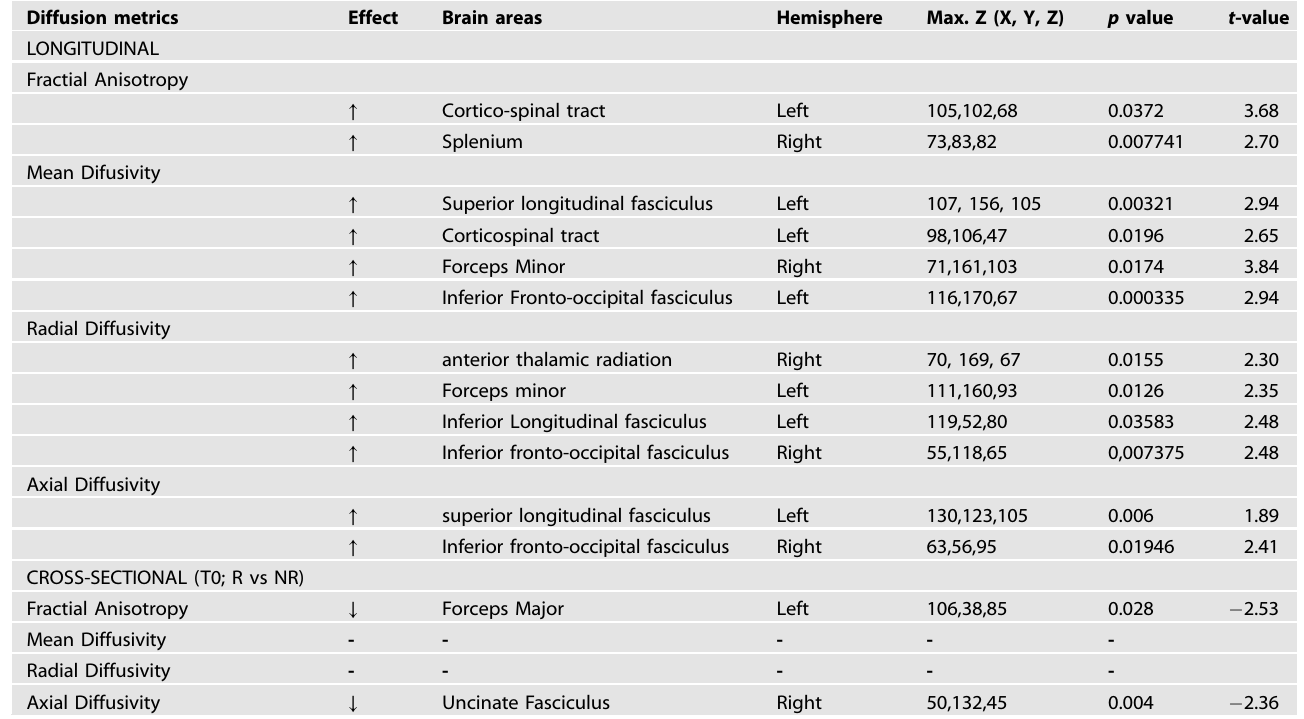
Table 2. Longitudinal and cross-sectional analysis of diffusion